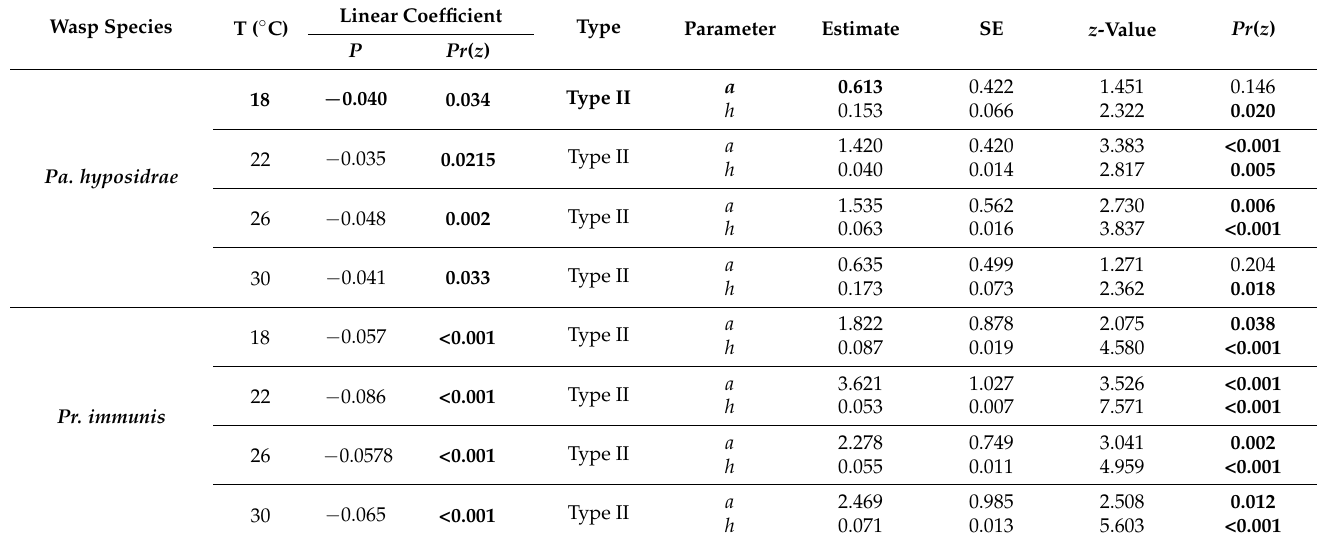
Table 1. Effects of temperatures on functional response parameters of Pa. hyposidrae and Pr. immunis towards E. grisescens based on the difference method model.